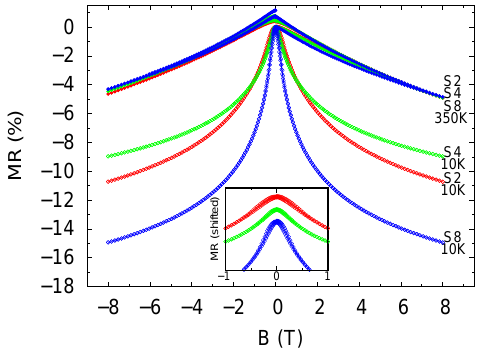
Fig. 3. Temperature dependence of the resistivity change for all the films in 0 T and 5 T magnetic fields. The inset shows the temperature dependence of magnetoresistance for all the films in 1 T and 5 T magnetic fields.